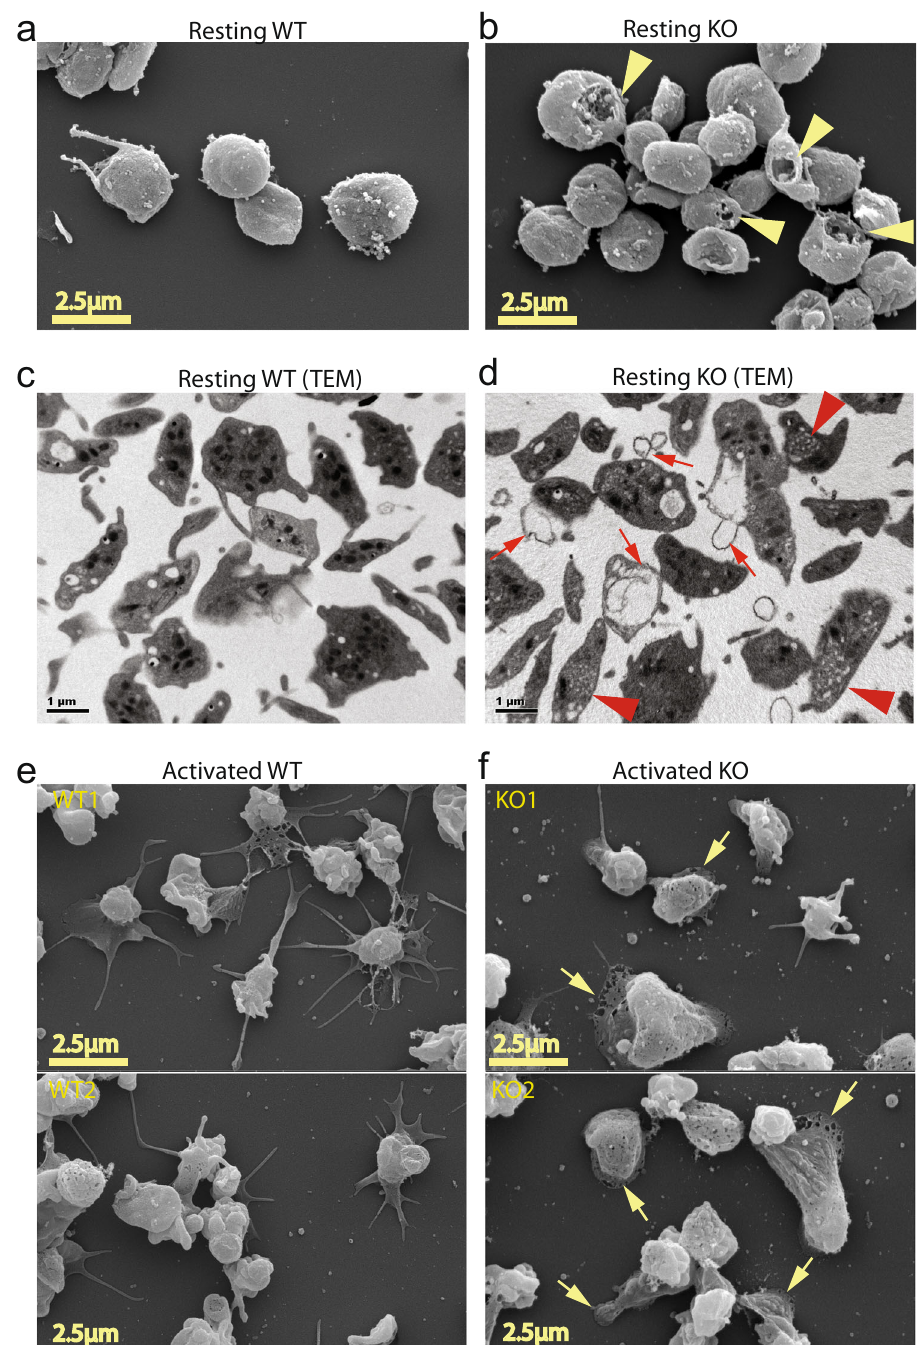
Fig. 6 Mfsd2b knockout platelets had abnormal morphology. a , b Representative images from scanning electron microscopic (SEM) of resting WT and Mfsd2b KO platelets. Note that KO platelets exhibited membrane damages (shown in yellow arrowheads). WT wild-type, KO knockout . c , d Representative images from transmission electron microscopic (TEM) of resting WT and KO platelets. Note that KO platelets exhibited increased membrane protrusion and blebbing, likely due to defects in the open canalicular systems (shown in red arrows). There were multiple small open canalicular systems (OCS) observed in KO cells (red arrowheads). e , f Representative images from scanning electron microscopic (SEM) of calcium ionophore A23187 (1 µ M) activated WT and KO platelets. Platelets were activated for 5 min on coverlips and fi xed. Note that activated KO platelets had reduced spreading and increased lamellipodia (shown in yellow arrows). In a – d , representative images from 3 WT and 3 KO mice. In e , f upper and lower panels are images from platelets isolated from two different animals ( n =